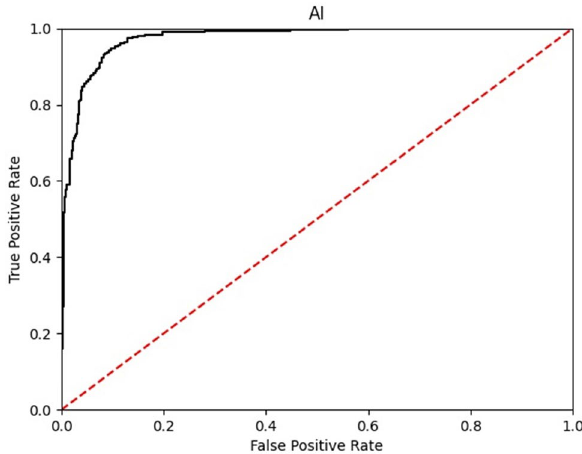
Figure 1. The AUC of AI-assisted diagnostic device. AI artificial intelligence, AUC area under the receiver operating